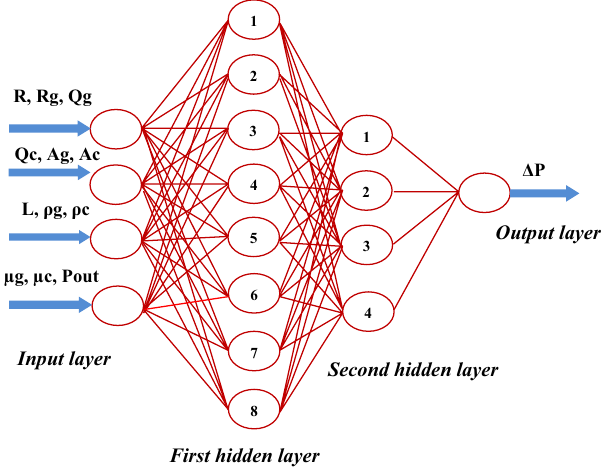
Figure 3. Input data and hidden layers of neural